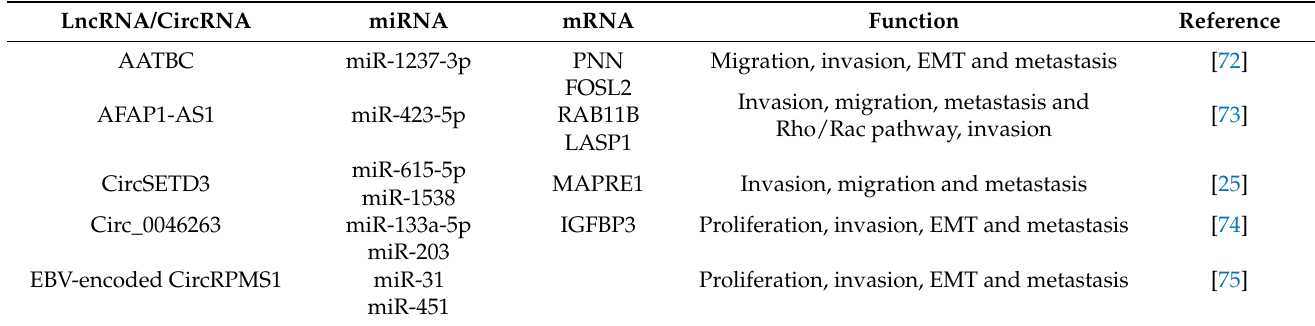
Table 4. CeRNA networks of lncRNA/circRNA-miRNA-mRNA involved in NPC